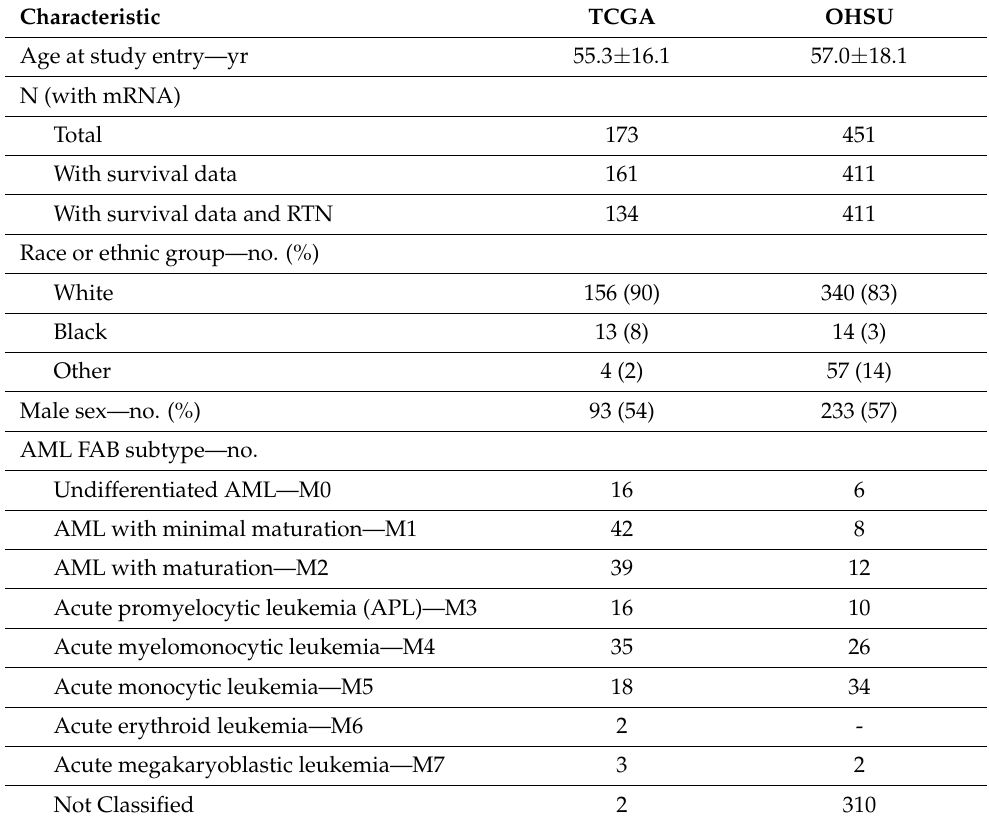
Table 1. Characteristics of the patients. The number of patients in each category is provided for both the discovery (TCGA) and independent validation set